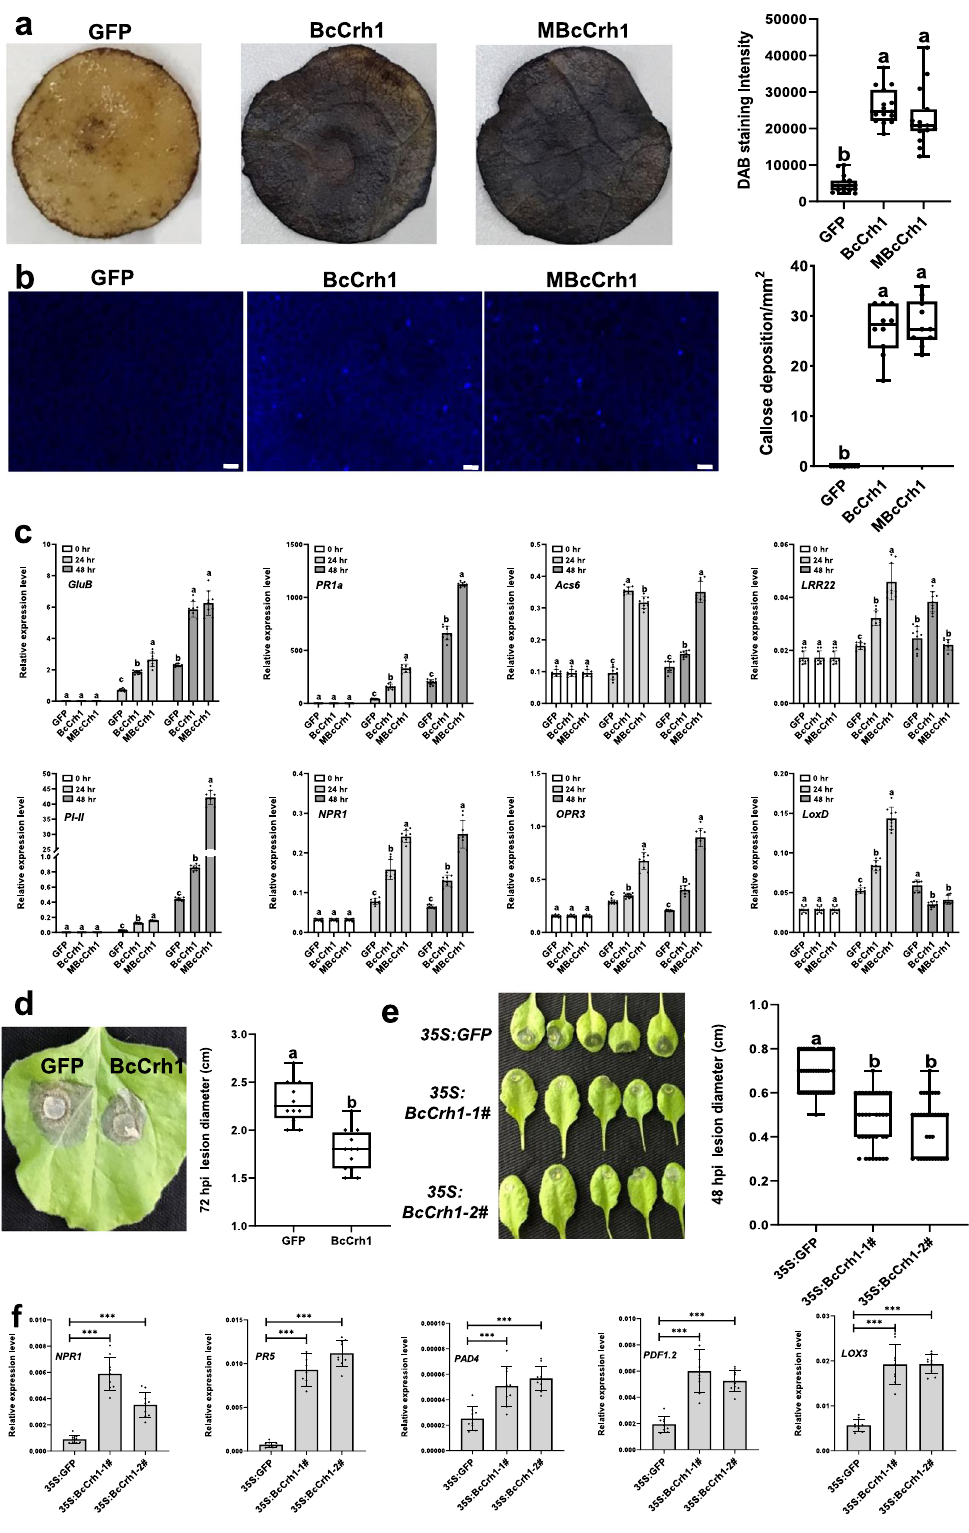
BcCrh1 is expressed in planta and secreted from infection cushions . Crh proteins are fungal cell wall transglycosylases 18 – 20 . Nevertheless, BcCrh1 was found in the fungal secretome and is internalized by the plant cells, where it triggers plant cell death and defense responses, implying that it also affects fungal-plant interaction. To gain insights into the possible role of BcCrh1